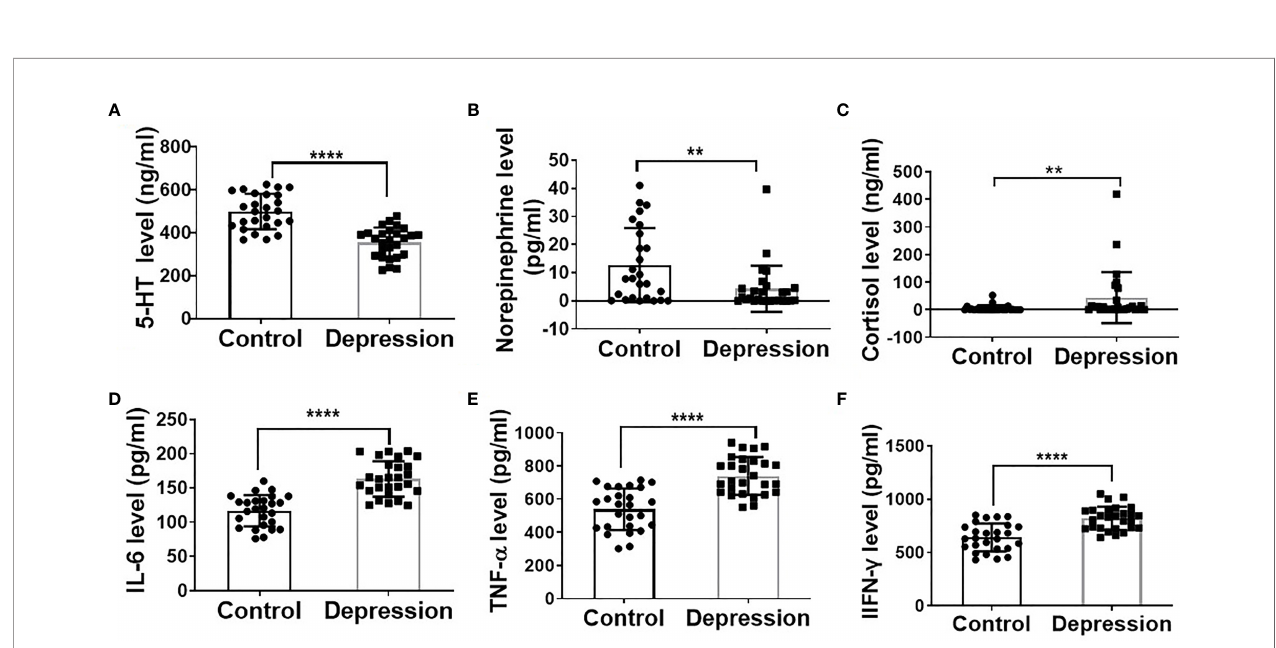
FIGURE 1 | Depression altered hormone levels and elevated in fl ammatory cytokine levels. Plasma levels of 5-HT (A) , norepinephrine (B) , cortisol (C) , IL-6 (D) , TNF- a (E) , and IFN- g (F) in depression patients ( n = 27) and mental healthy volunteers ( n = 26); ** p < 0.01, **** p < 0.0001.